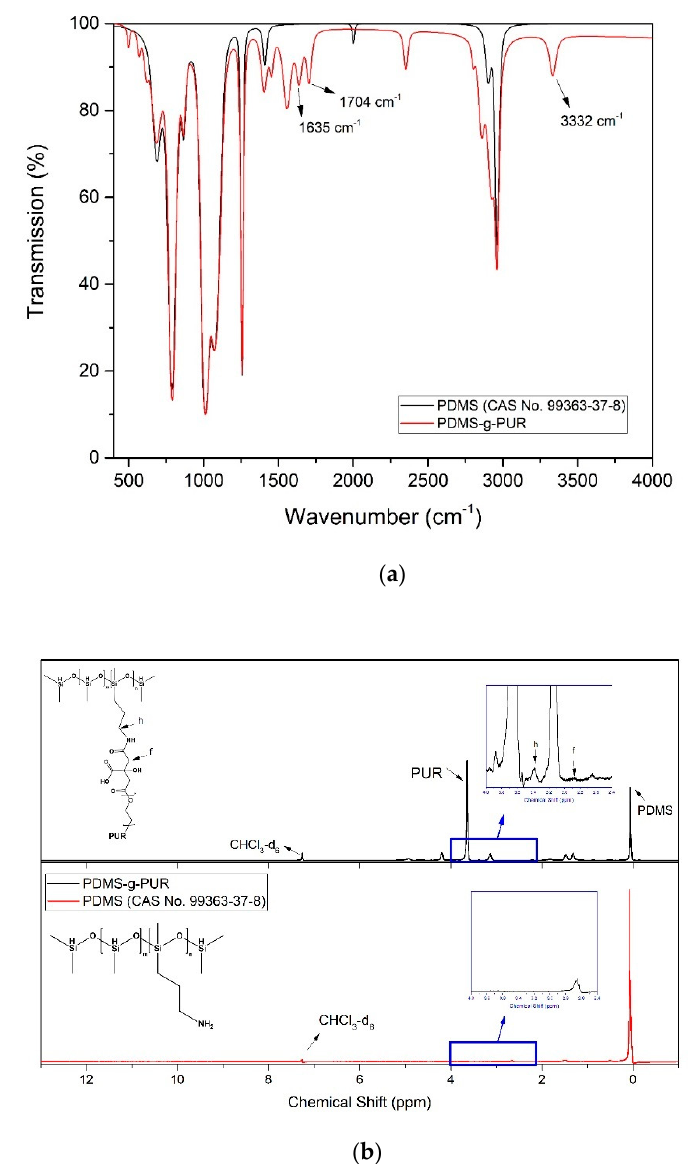
Figure 5. ( a ) Comparison of FTIR spectra of PDMS- g -PUR ( red ) and PDMS ( black ) and ( b ) 1 H NMR spectra of PDMS -g- PUR and commercial PDMS (which is used to synthesize graft copolymer).